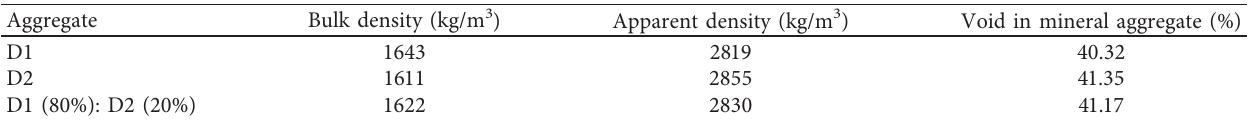
Table 2: Coarse aggregate properties.